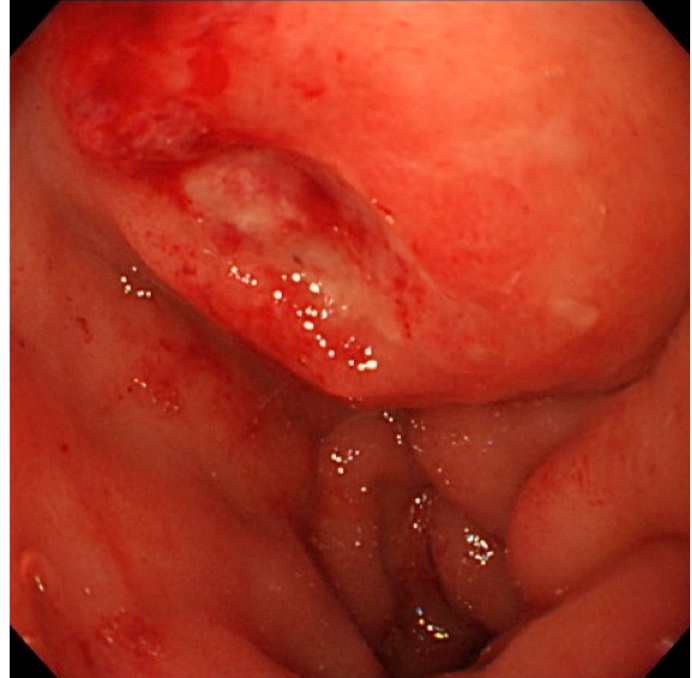
Figure 2. Endoscopic view of the duodenal bulbs. A hemispheric submucosal tumor with apical erosion was recognized.